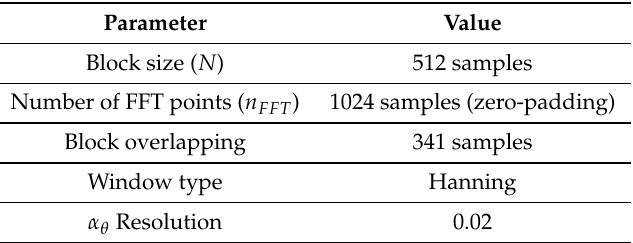
Table 2. Parameters used by the CPD algorithm to estimate the OFSC function through the Welch